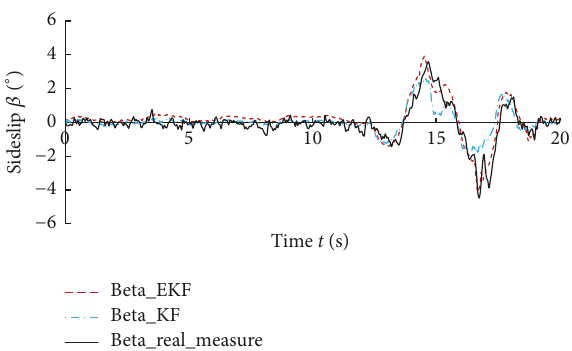
Figure 11: Sideslip angle identification values compared with the experimental value under line